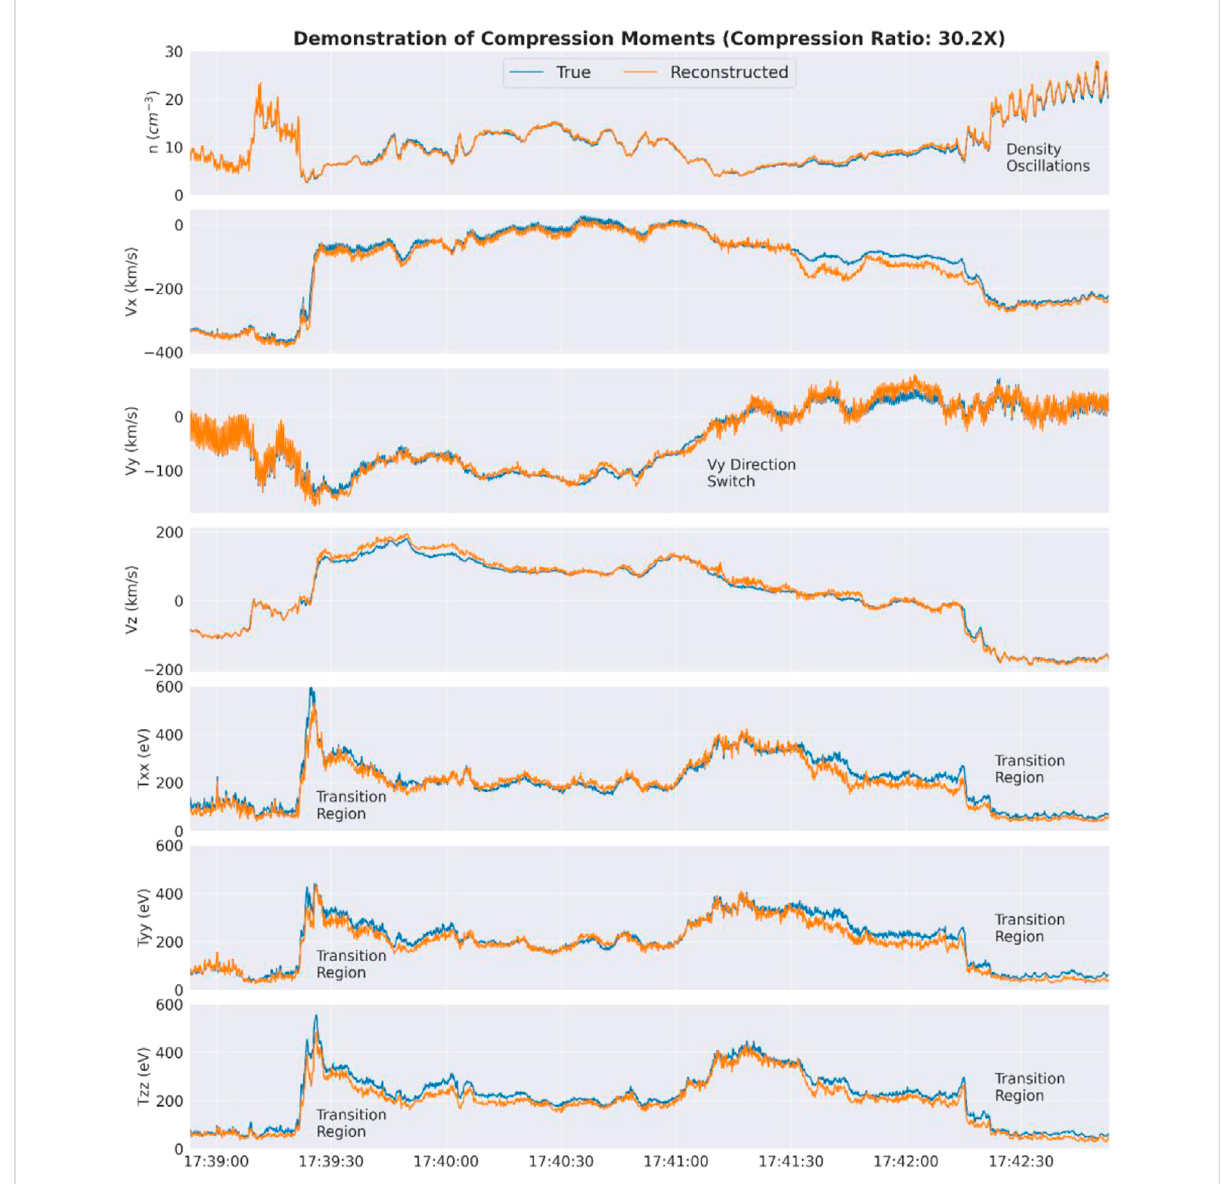
FIGURE 4 A time series comparison of moments from the original and reconstructed versions of the data. This is using the full end-to-end compression algorithm outlined in the Demonstration of Compression Algorithm section, including quantization and entropy coding. This is the same interval displayedinspectrogramfromthatsection.Thiscomparisonshowsgoodagreementinthemomentsofthedata,whereinananalysislookingatonly the reconstructed moments would come to similar conclusions about the plasma environment as if the original moments were used. The Txx, Tyy, and Tzz variables are the diagonal elements of the temperature tensor. All coordinates are in the GSE coordinate